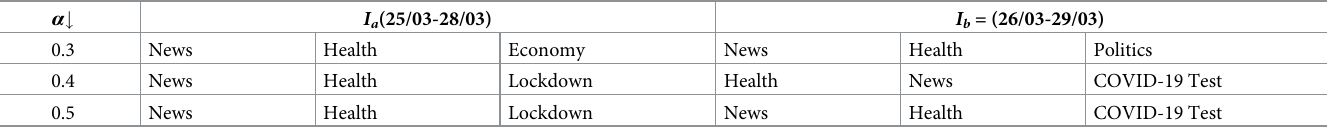
Table 2. Top- k trending topics for different values of α .